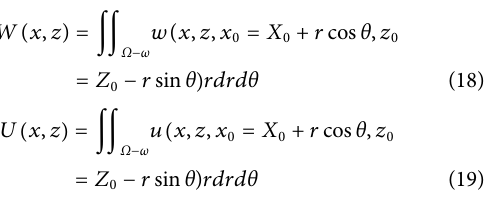
Frontiers in Earth